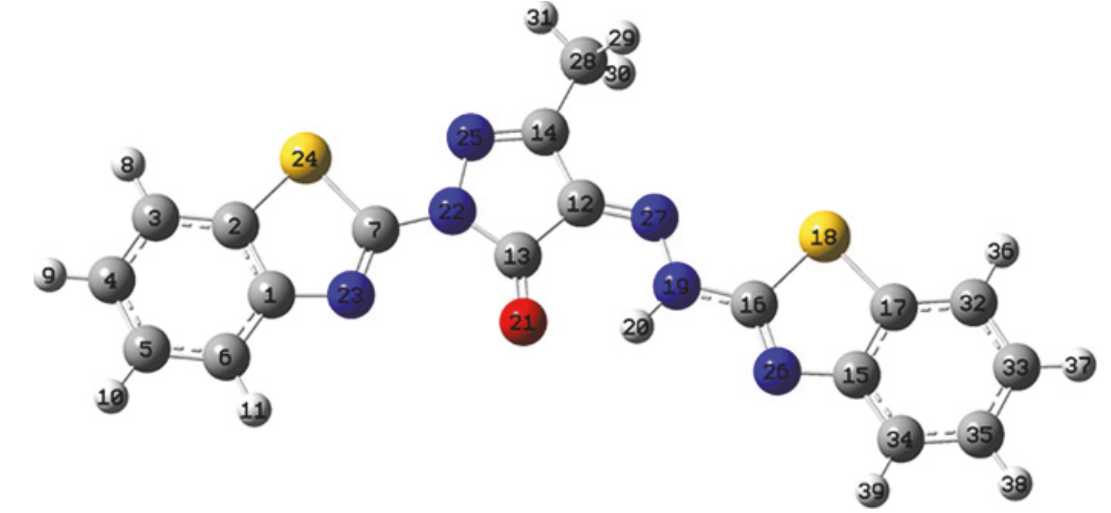
Figure 4: Computed optimized ground state geometry with atomic numbering of dye 3a using DFT.